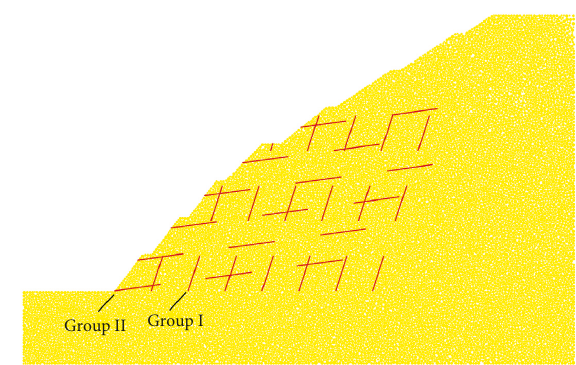
Figure 6: Discontinuous jointed rock slope model.